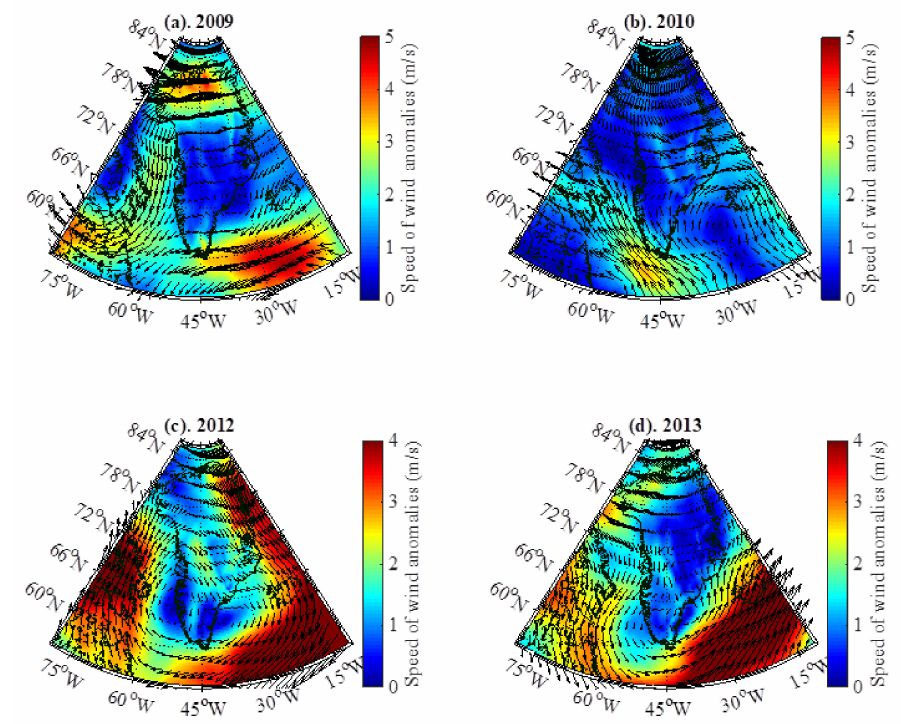
Figure 14. Summer wind anomalies in: ( a ) 2009, ( b ) 2010, ( c ) 2012, and ( d )